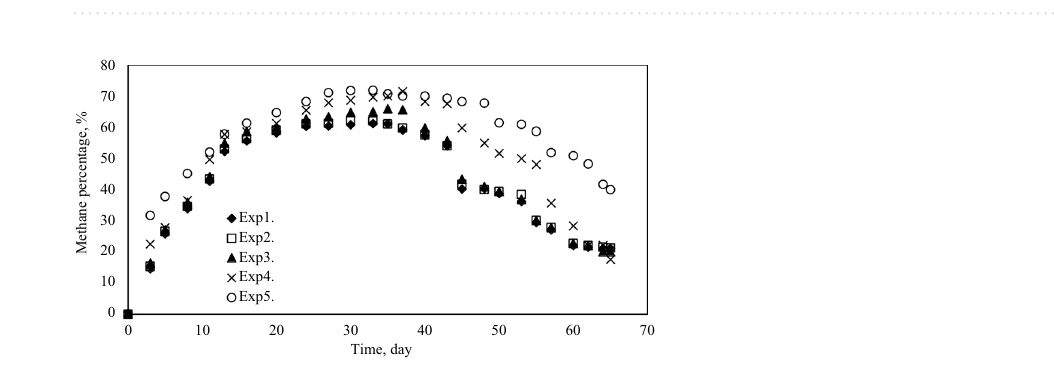
Figure 3. Cumulative methane production.